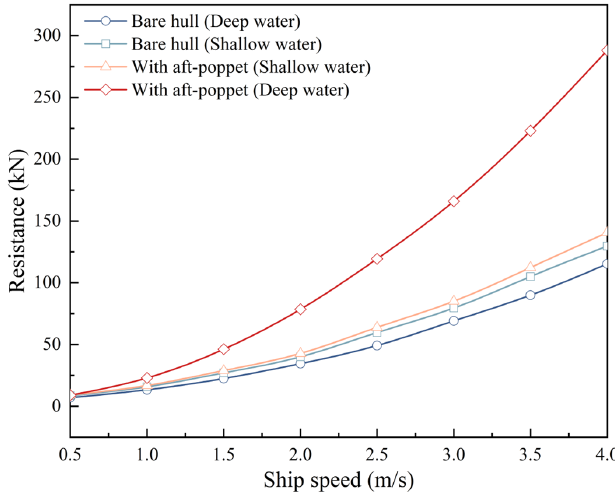
Figure 11. Ship resistance curves under deep- and shallow-water